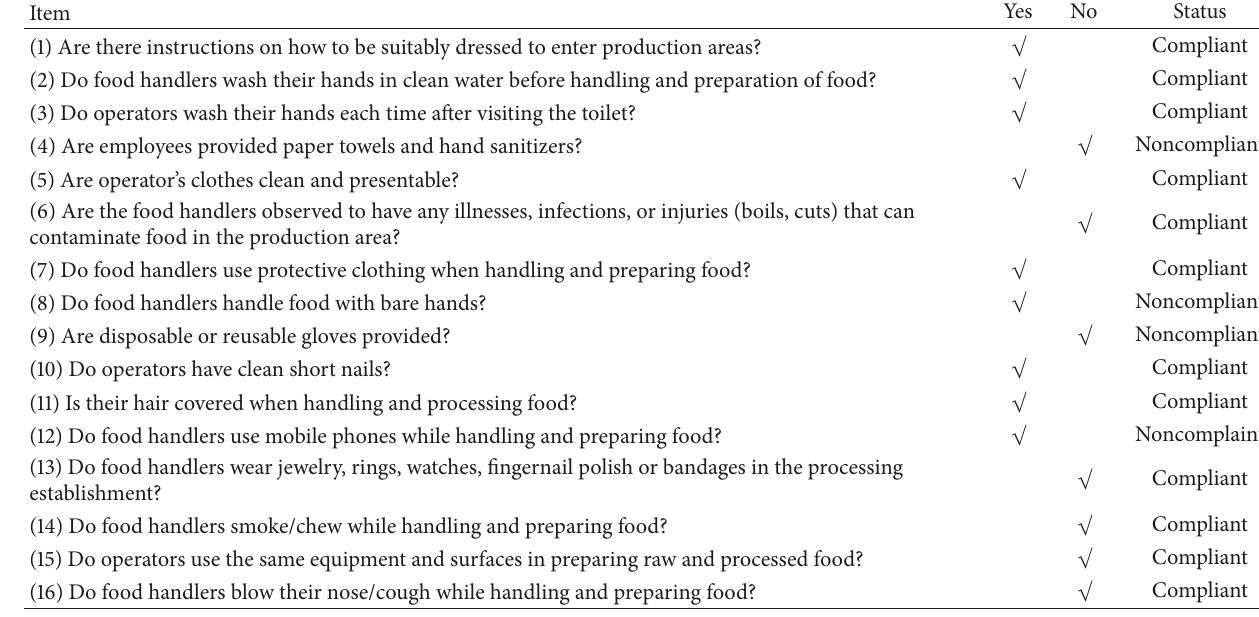
Table 7: Assessment of personal hygiene practices in OFSP puree processing. Item Yes No Status